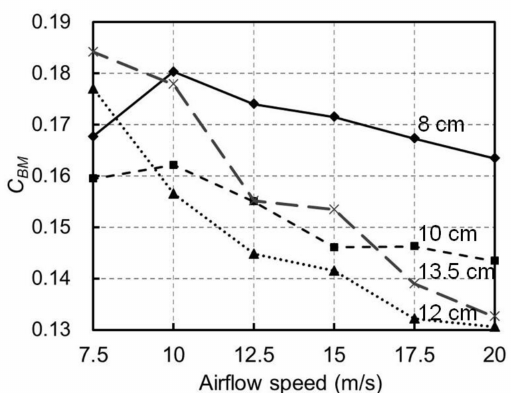
Figure 10. E ff ects of the airflow speeds on the overturning-moment coe ffi cient C BM of the bridge with di ff erent wind barrier